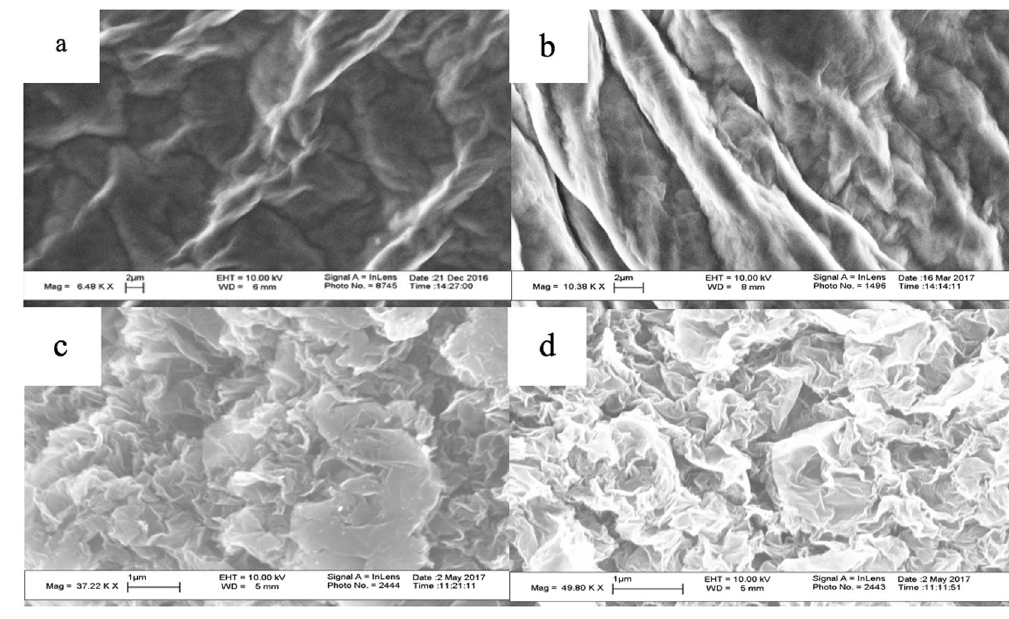
Figure 1. SEM images of ( a ) GO, ( b ) r-GO-31, ( c ) r-GO-19, ( d )